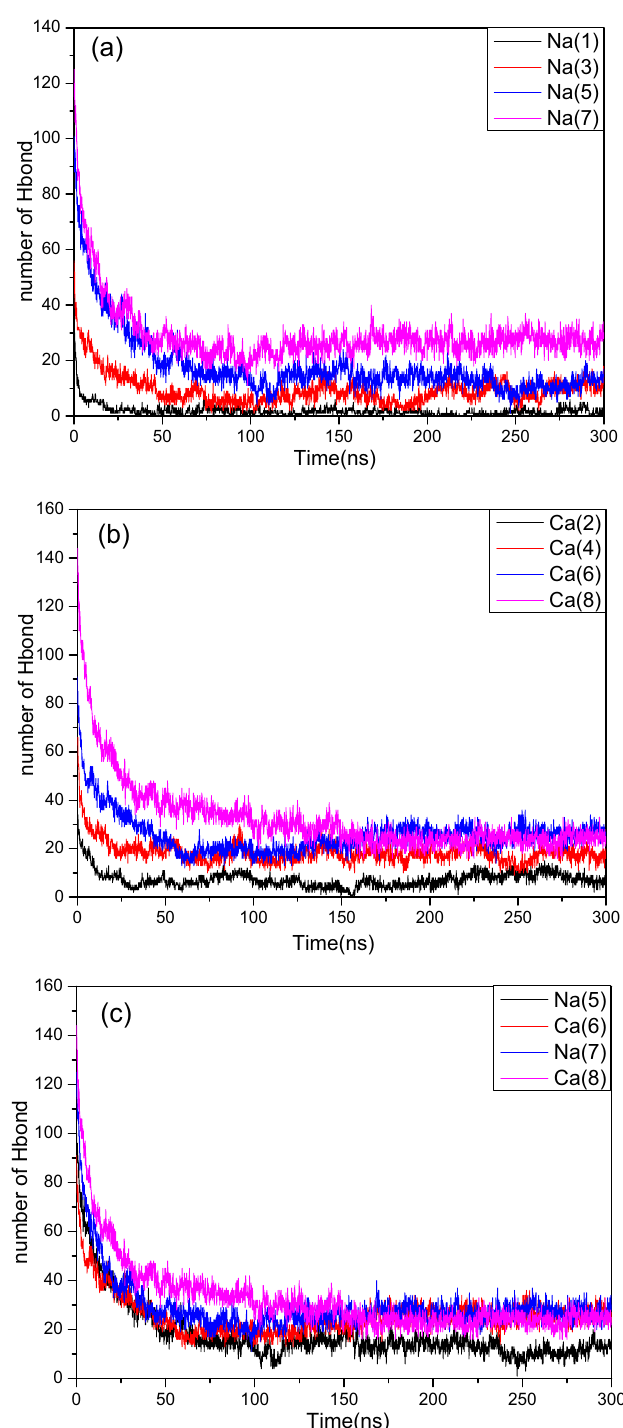
Figure 3. The number of hydrogen bonds between the dipeptides (2NapFF). ( a ) Na carboxylate system (1, 3, 5, 7); ( b ) Ca carboxylate system (2, 4, 6, 8); ( c ) the Ca 2+ system(6, 8) forming gel corresponds the Na + system(5, 7) with the same dipeptides